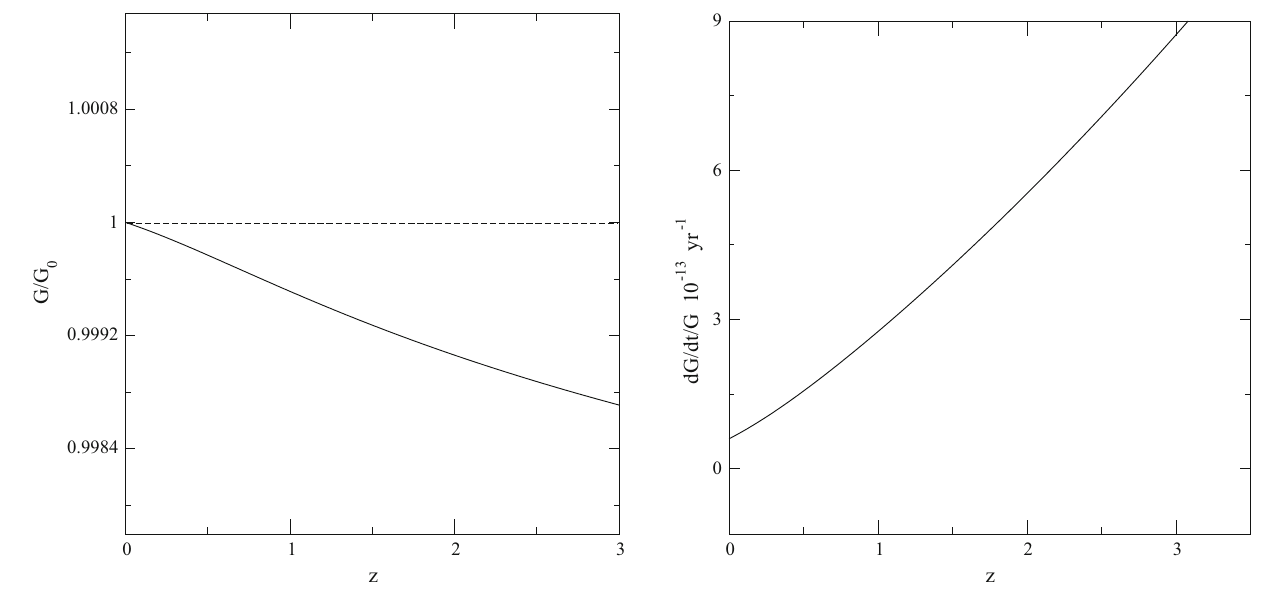
we plot the cosmic drift rate ˙ G / G of the gravitational coupling as a function of the redshift, according to the RVM equation (30)